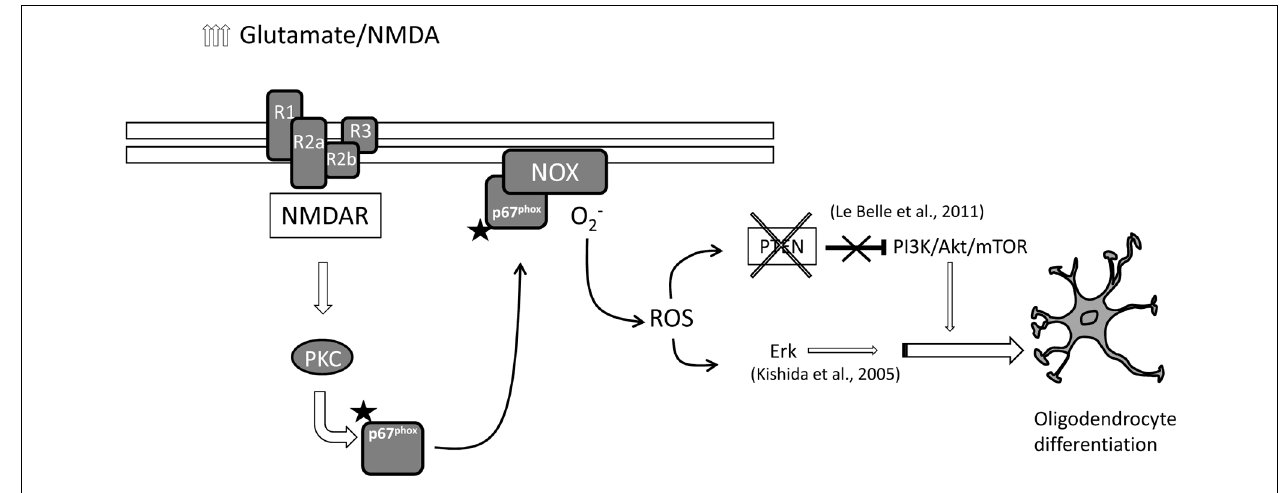
PKC/NOX/p67 signaling. Activated NOX generates intracellular ROS that in parallel can set off PI3K/mTOR and/or ERK pathways to induce oligodendrocyte